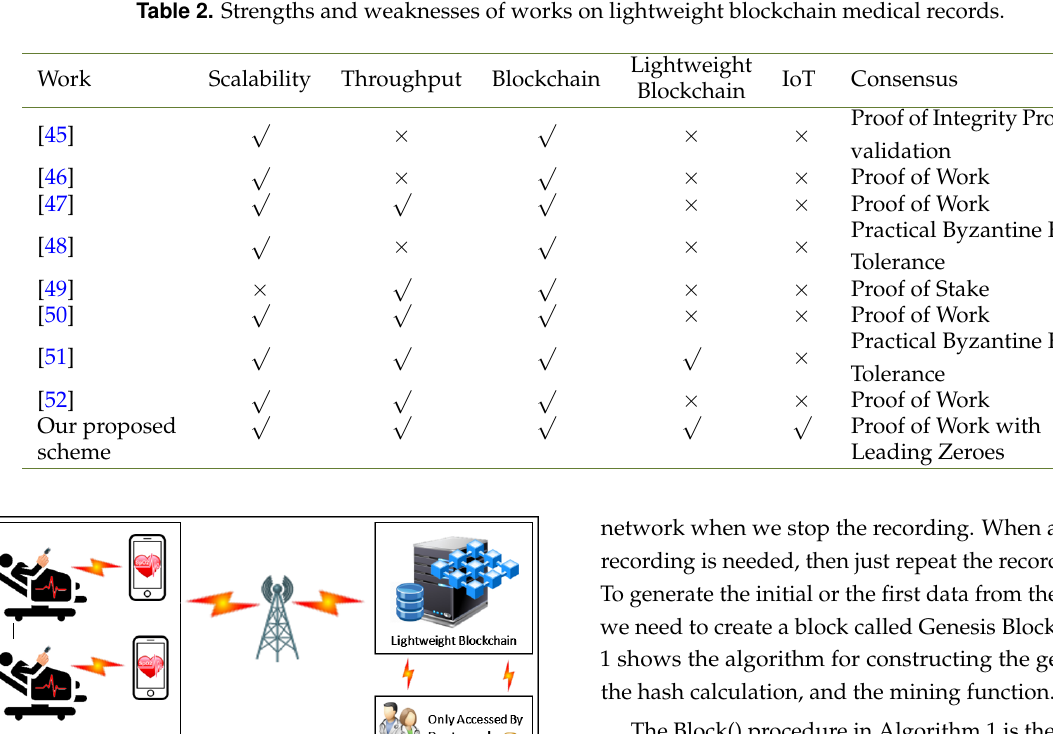
Table 2. Strengths and weaknesses of works on lightweight blockchain medical records.